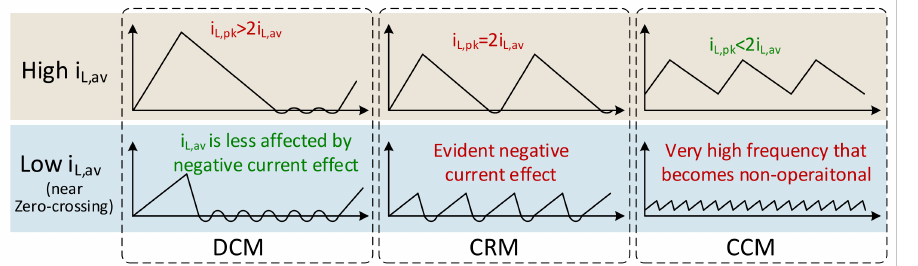
Figure 4. Inductor currents under different operation modes considering switching transients and current